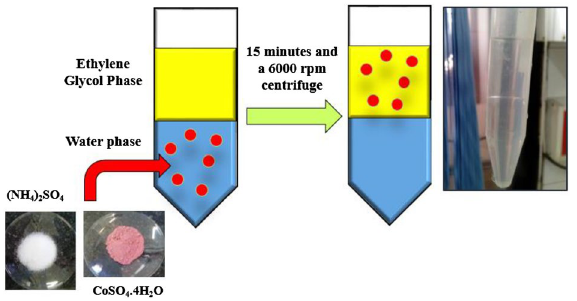
Figure 1. Schematic of procedure for cobalt extraction with an aqueous two-phase system.